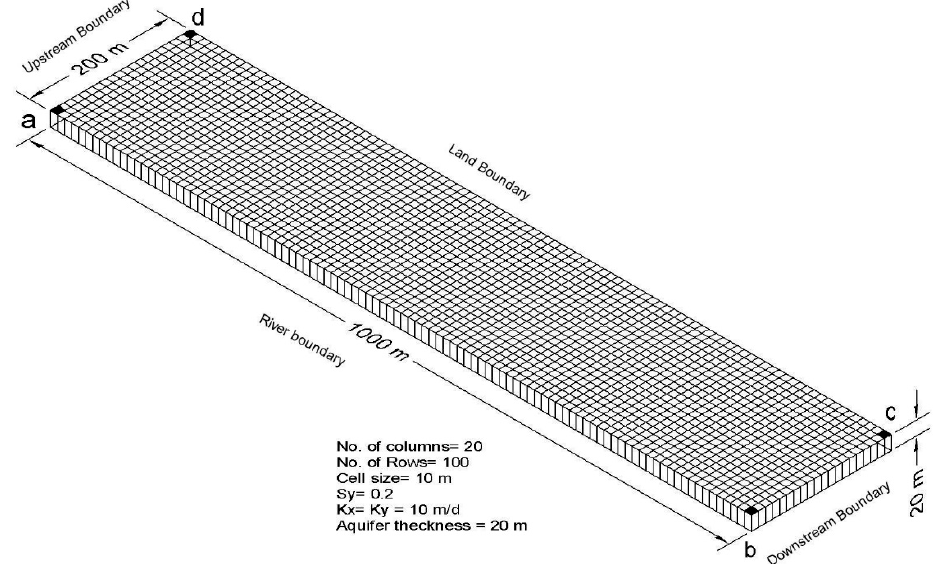
Figure 8. Concept of the groundwater model as simulated with STRIVE and MODFLOW. The heads along the upstream (ad), land side (dc) and downstream (bc) boundaries are specified and interpolated based on four corner heads derived from the original groundwater model (a = 10.5 m, b = 10.2 m, c = 10.5 m, d = 10.8 m).